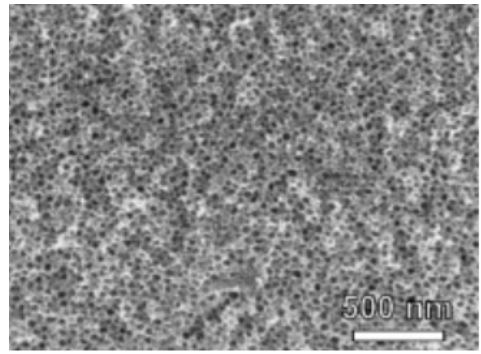
Figure 2. The SEM images of mNiO after calcination [32].